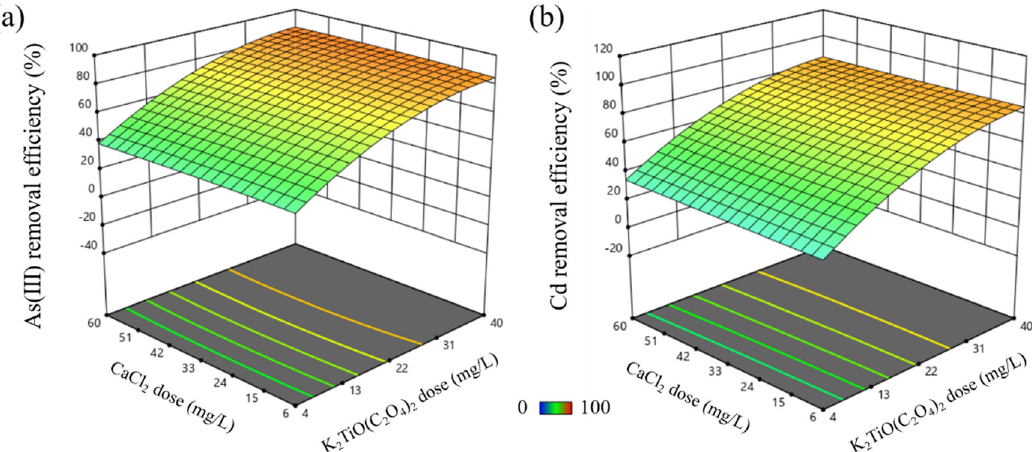
Fig. 3 The effect of CaCl 2 dose on As(III) and Cd removal ef fi ciencies. ( a ) As(III) removal ef fi ciency, and ( b ) Cd removal ef fi ciency. Other conditions were initial As(III) concentration of 250 μ g/L, Cd concentration of 250 μ g/L, and pH of 7.